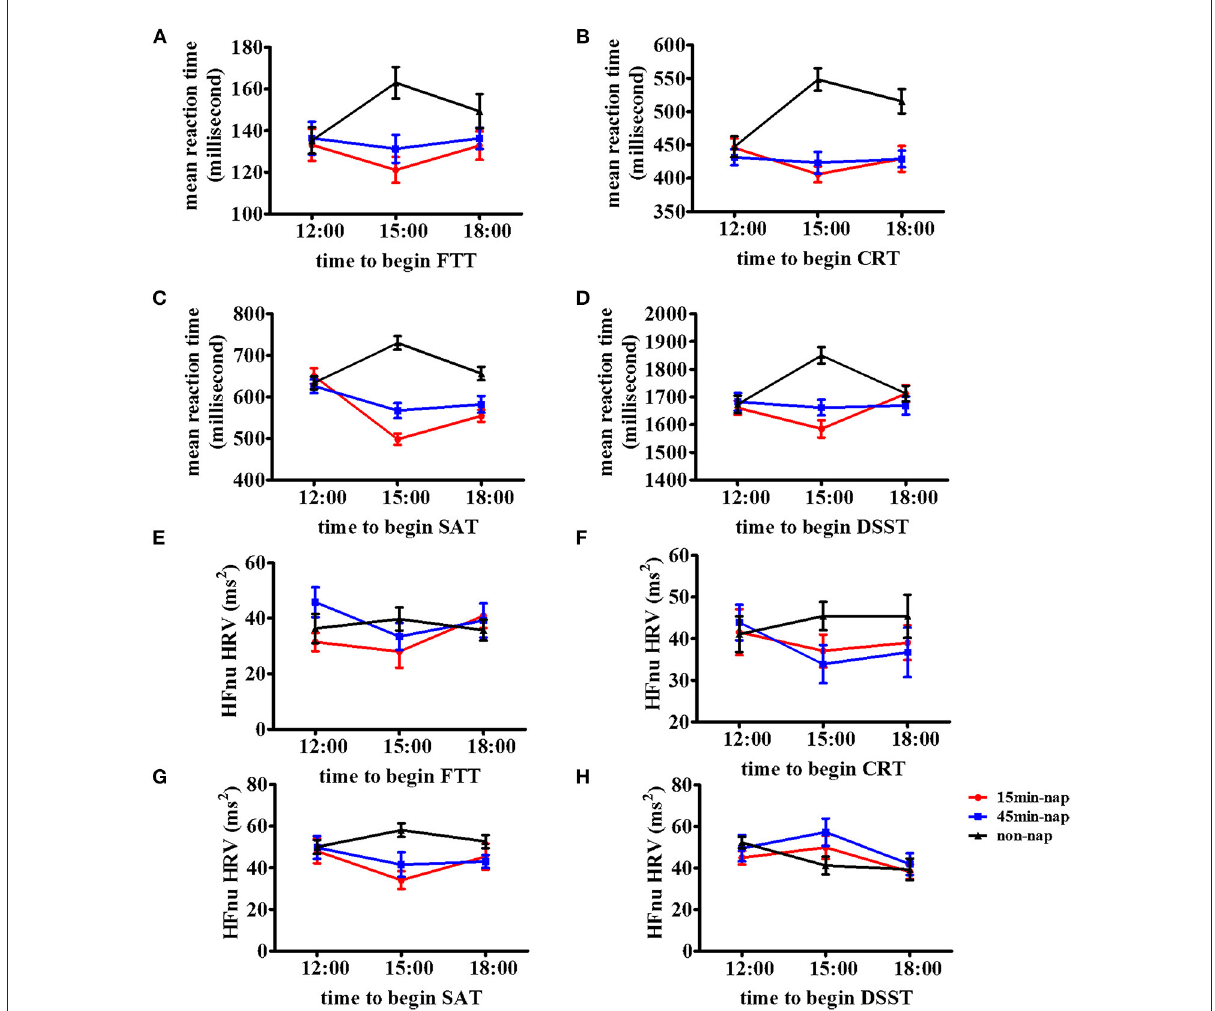
FIGURE2 Mean and stand deviations of cognitive tests and resting vmHRV of the time course in the three nap groups. Means and standard deviations are shown for four outcome metrics of the cognitive tests and resting vmHRV among three nap groups (non-nap, 15-min nap, and 45-min nap). Time course of the (A) FTT performance, (B) CRT performance, (C) SAT performance, (D) DSST performance, (E) HFnu (FTT), (F) HFnu (CRT), (G) HFnu (SAT), and (H) HFnu (DSST) in participants under nonnap group (lines with triangle), 15-min nap group (lines with square), or 45-min nap group (lines with